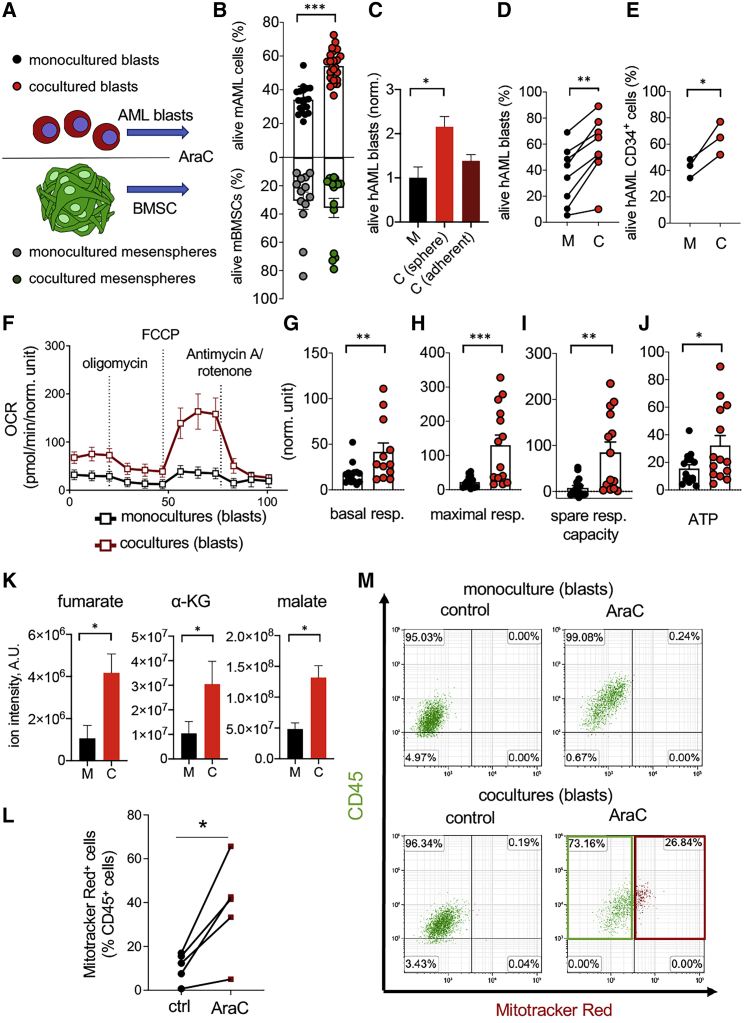
BMSCs Support Leukemic Blast Survival, Chemoresistance, and Bioenergetics(A) Scheme showing the different culture conditions and cells tested.(B) Frequency of alive (AnnexinV−DAPI−) cells 24 h after AraC treatment (n = 19).(C) Frequency of alive human AML cells monocultured (M) or cocultured (C) with human mesenspheres or adherent BMSCs for 24 h under AraC treatment (n = 3–5). ∗p < 0.05; One-way ANOVA and Bonferroni comparisons.(D and E) Frequency of alive CD45+ (D, n = 8) cells or CD34+ HSPCs (E, n = 3) from human AML BM 24 h after AraC in monoculture (black) or coculture (red) with BMSCs expanded as mesenspheres from AML patients (n = 8). ∗p < 0.05; ∗∗p < 0.01; paired two-tailed t test.(F) OCR indicating mitochondrial respiration after oligomycin, FCCP and antimycin A/rotenone treatment in leukemic blasts cultured alone or previously cocultured with mesenspheres for 24 h in presence of AraC.(G–J) Seahorse measurement of basal respiration (G), maximal respiration (H), spare respiratory capacity (I), and ATP content (J) in murine leukemic blasts monocultured (black columns) or cocultured with BMSCs (red columns); n = 6 independent experiments. Data represent mean ± SEM. ∗p < 0.05; ∗∗p < 0.01; ∗∗∗p < 0.001; unpaired two-tailed t test.(K) Levels of the TCA cycle metabolites fumarate, ɑ-KG, and malate measured by LC-MS in murine leukemic blasts monocultured (black columns) or cocultured with BMSCs (red columns); n = 5 independent experiments with 4 biological replicates each.(L) Frequency of AML blasts uptaking MitoTracker Red+ mitochondria previously stained in BMSCs only, before the coculture with AML cells under AraC treatment; n = 4 independent experiments; ∗p < 0.05; paired two-tailed t test.(M) Representative flow cytometry diagrams showing CD45 (green) and MitoTracker Red (red) fluorescence in murine AML blasts monocultured or cocultured with BMSCs, which were previously stained with MitoTracker Red to label their mitochondria. The frequencies of gated cell populations are indicated. The red box highlights the increased frequency of BMSC-derived mitochondria in AML cells after AraC treatment.